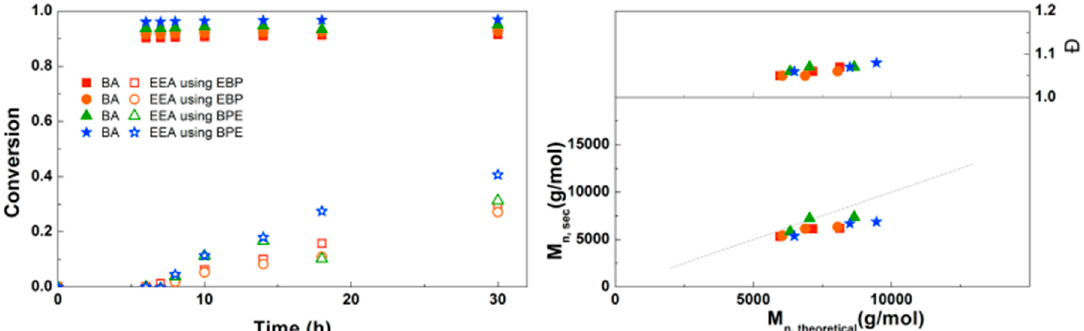
Figure 10. ( Left ): conversion versus time plot for Cu(0)-mediated one-pot block copolymerization of BA and EEA using [BA]:[EEA]:[EBP]:[Me 6 TREN]:[CuBr 2 ] = 50:50:1:0.15:0.1 and [BA]:[EEA]:[BPE]:[Me 6 TREN]:[CuBr 2 ] = 50:50:1:0.3:0.2, 3.0 M in DMF at 25 °C and 12.5 mm 2 /mL Cu(0) wire. A 3.0 M solution of EEA in DMF was added after 6 h reaction time. ( Right ): corresponding molecular weight and dispersity versus theoretical molecular weight plot.